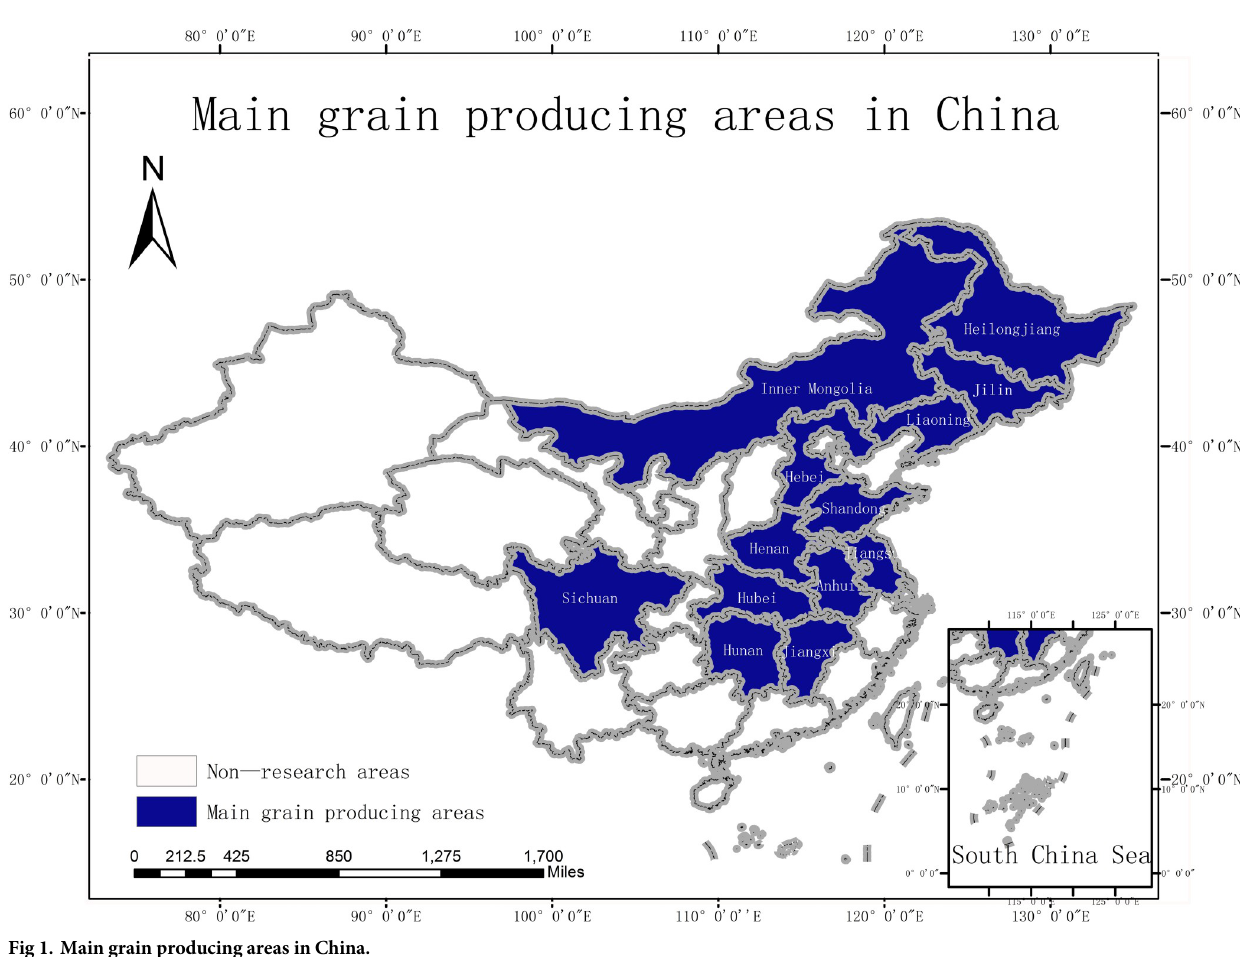
Fig 1. Main grain producing areas in